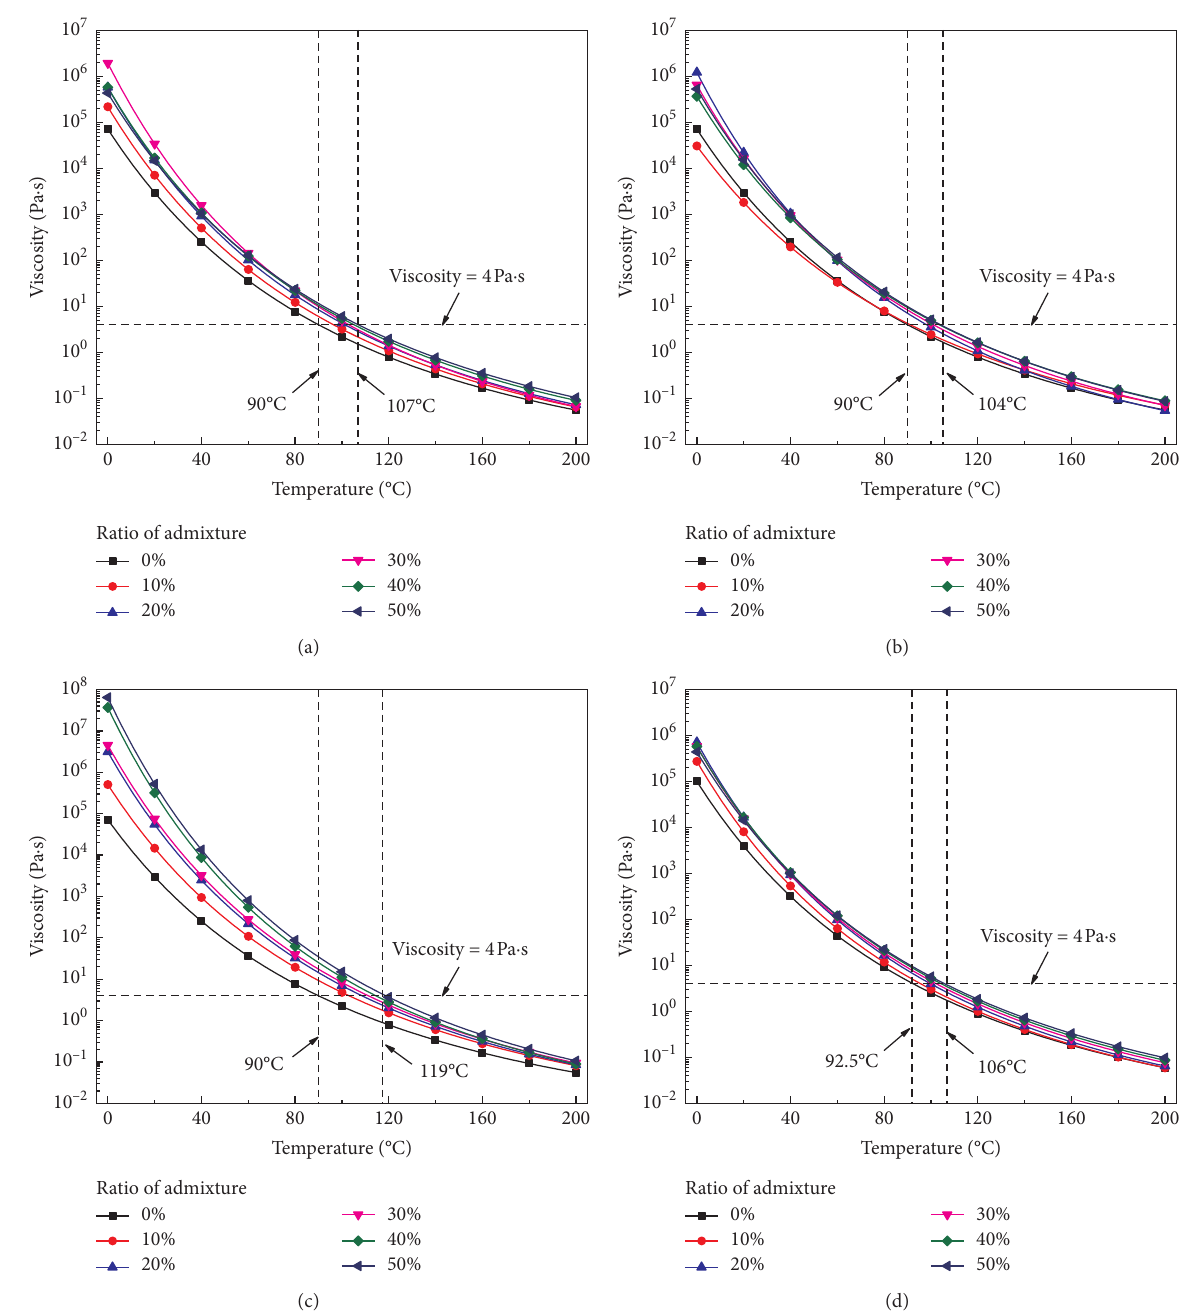
Figure 7: Relationship between viscosity and temperature. (a) R1. (b) R2. (c) R3. (d) R4.